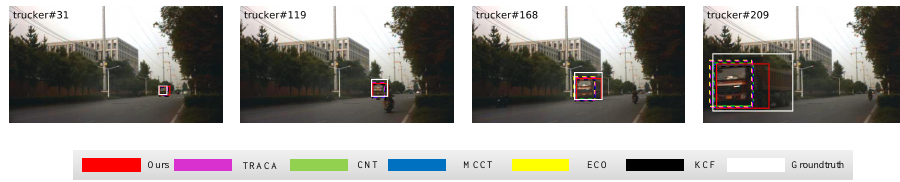
Figure 25. Qualitative results on the truck sequence in